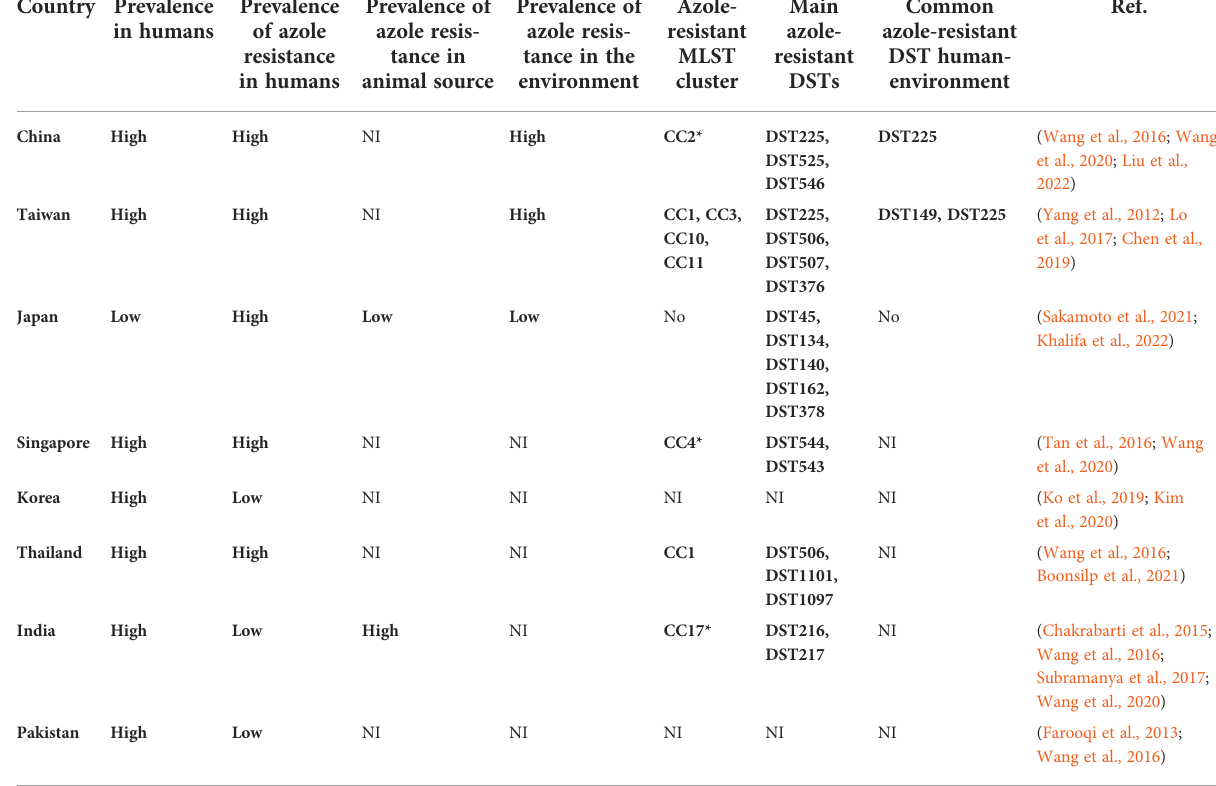
TABLE 2 Prevalence of Candida tropicalis from different Asian countries, niches, and multilocus sequence typing data. Country Prevalence in